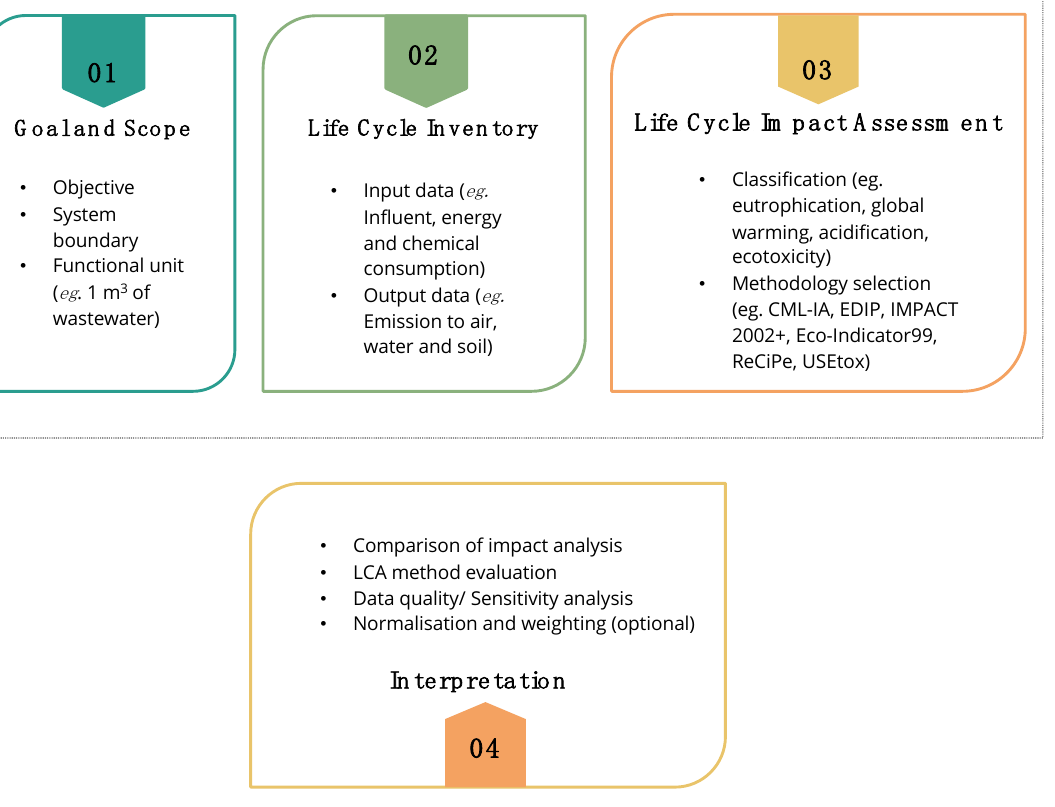
Figure 4. LCA methodology steps for environmental impact assessment from WWTPs.